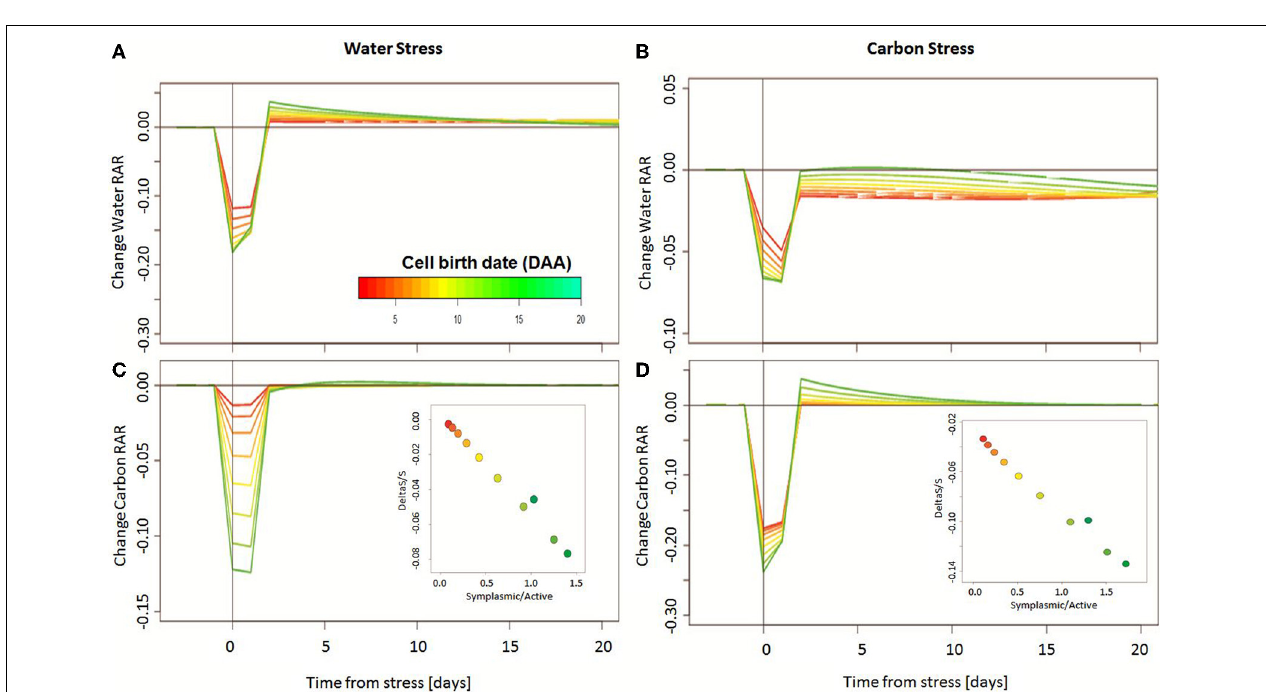
FIGURE 8 | Change in simulated cell water and carbon relative accumulation rate (RAR) after the application of a 24-h water deficit (A,C) or carbon limitation (B,D). Stress is applied at 20 DAA. The colors refer to cell age, red being the oldest and green the youngest, at the time of stress. Inset: following the application of